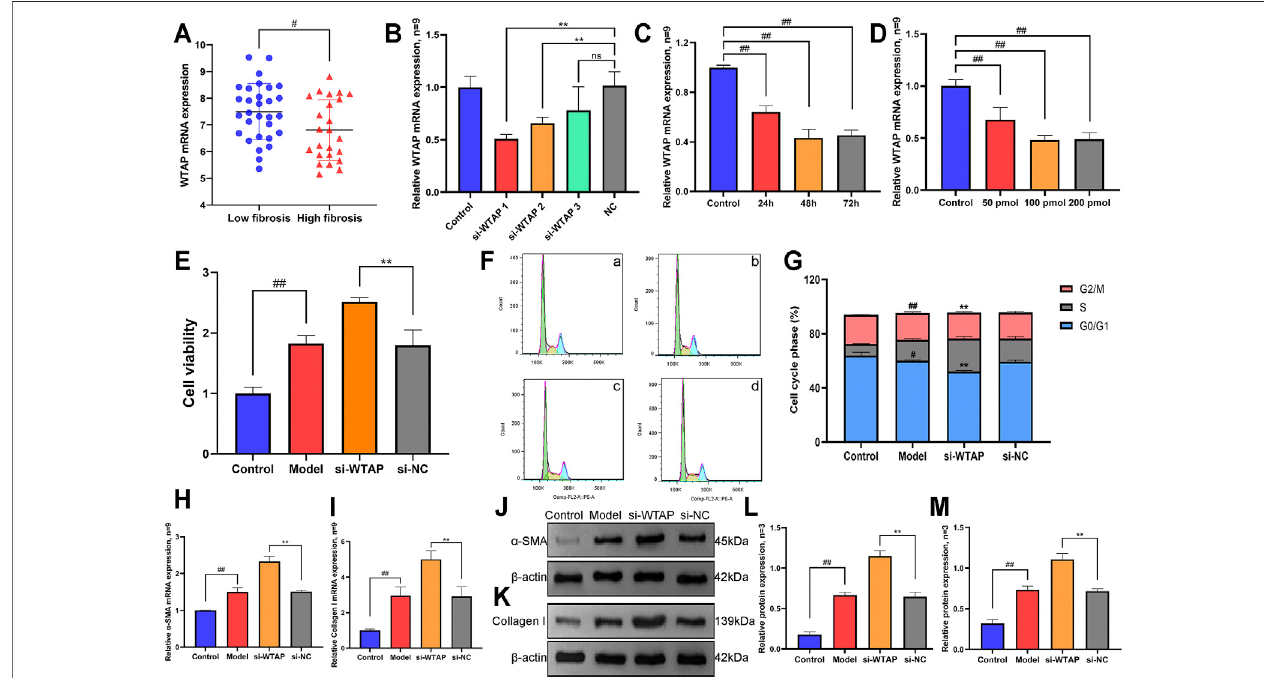
FIGURE 8 | Effects of methyltransferase WTAP on proliferation, cell cycle and activation markers of HSCs. (A) Expression levels of WTAP in low- fi brosis and high- fi brosis samples derived from the GEO database. (B) Small interfering RNA of WTAP was screened by RT-qPCR assay. (C) Optimal stimulation time of WTAP small interfering RNA was screened by RT-qPCR assay. (D) Optimal stimulation concentration of WTAP small interference RNA was screened by RT-qPCR assay. (E) Cell proliferation was detected by CCK8 assay. (F) The phase of the cell cycle was detected by fl ow cytometry. a, control group. b, model group. c, si-WTAP group. d, si-NC group. (G) Quanti fi cation ofthecellcycleresults. (H) mRNAexpression levelof α -SMA. (I) ThemRNAexpressionlevel ofcollagen Ⅰ . (J) Proteinexpression levelsof α -SMA. (K) Protein expression levels of collagen Ⅰ . (L) Semiquantitative analysis of α -SMA protein. (M) Semiquantitative analysis of collagen Ⅰ protein.